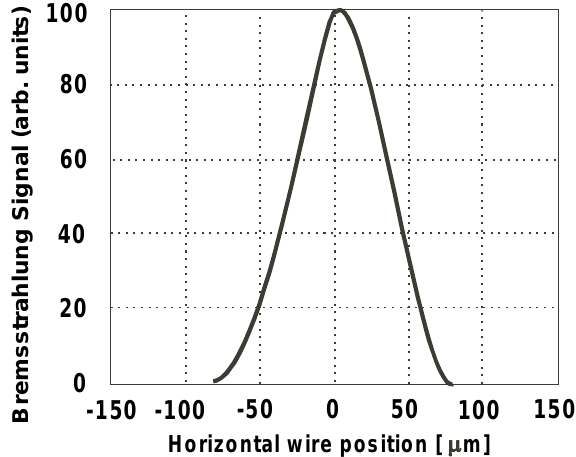
FIG. 6. Horizontal projection of the CO 2 laser focal intensity profile observed with the IR